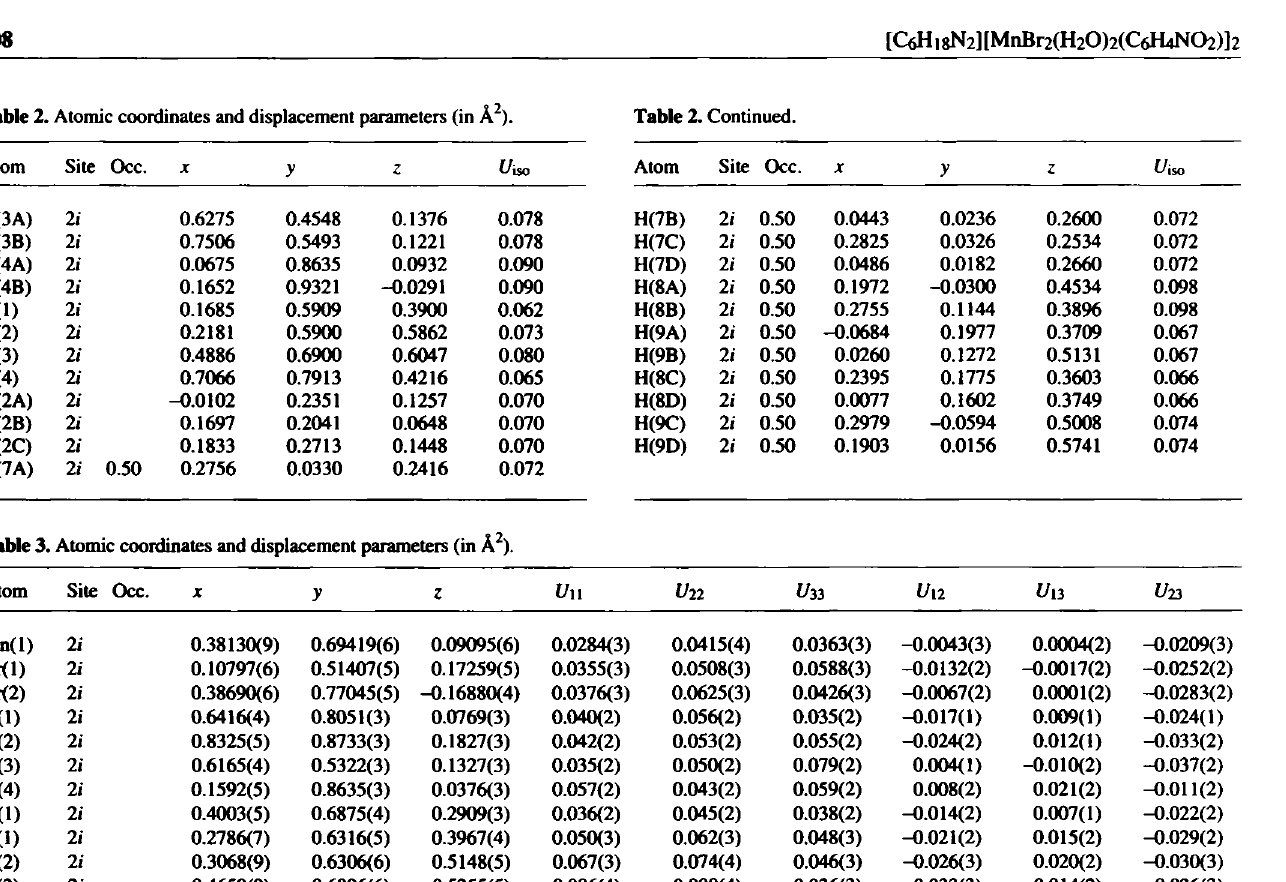
Table 3. Atomic coordinates and displacement parameters (in Â 2